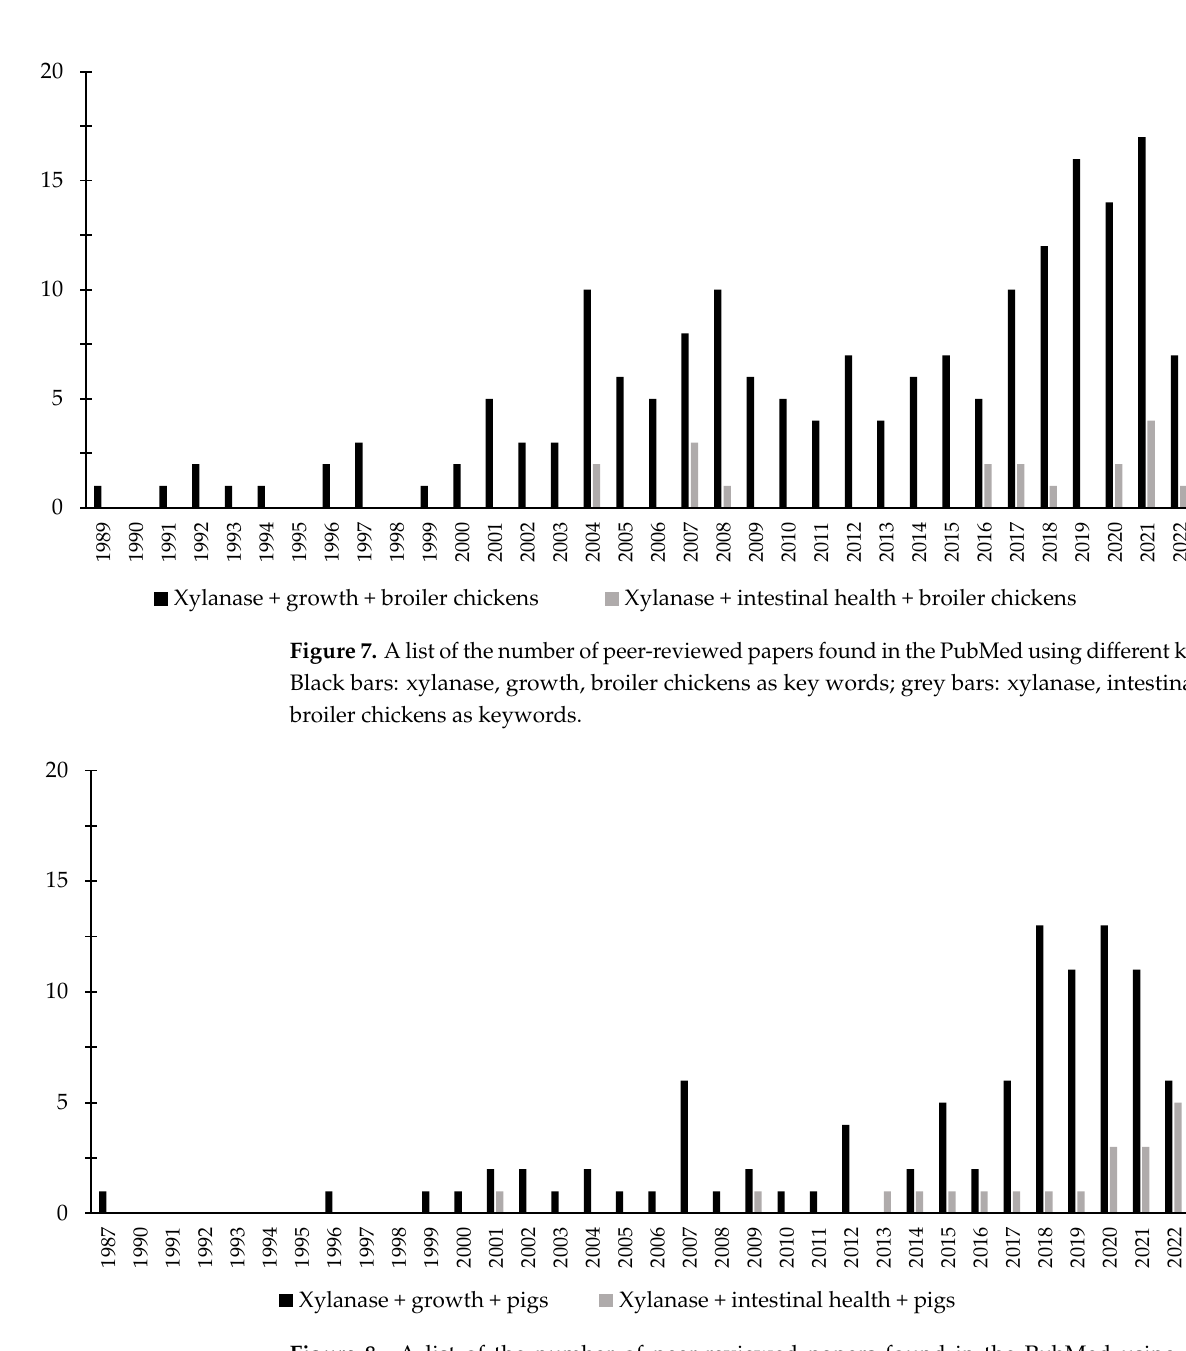
Figure 8. A list of the number of peer-reviewed papers found in the PubMed using different keywords. Black bars: xylanase, growth, pigs as key words; grey bars: xylanase, intestinal health, pigs as